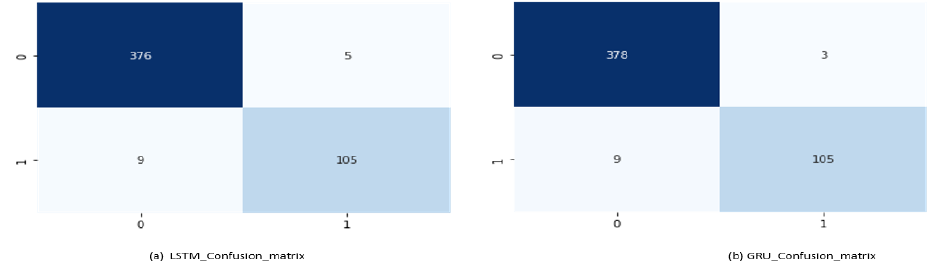
Figure 6. The loss and the accuracy curve of LSTM_model.